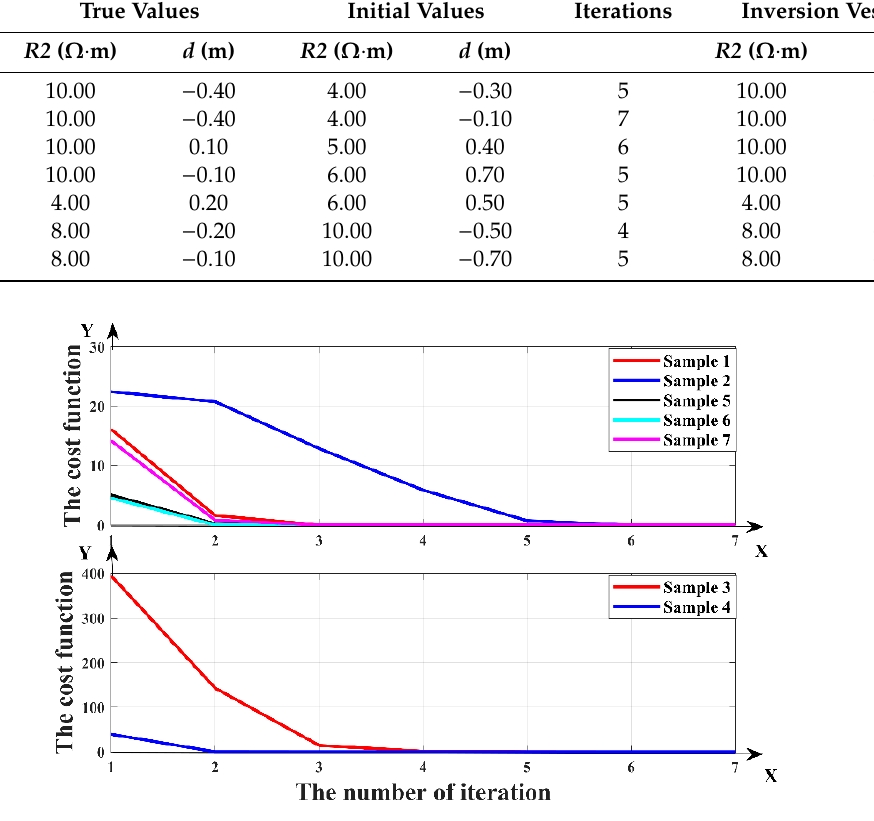
Figure 7. The cost function of the two-parameter inversion varying with the number of iterations.